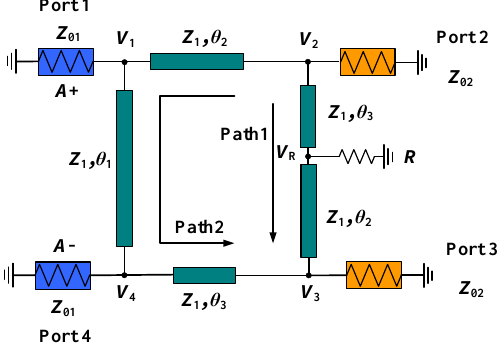
Figure 1. The proposed balanced-to-unbalanced (BTU) arbitrary power divider.